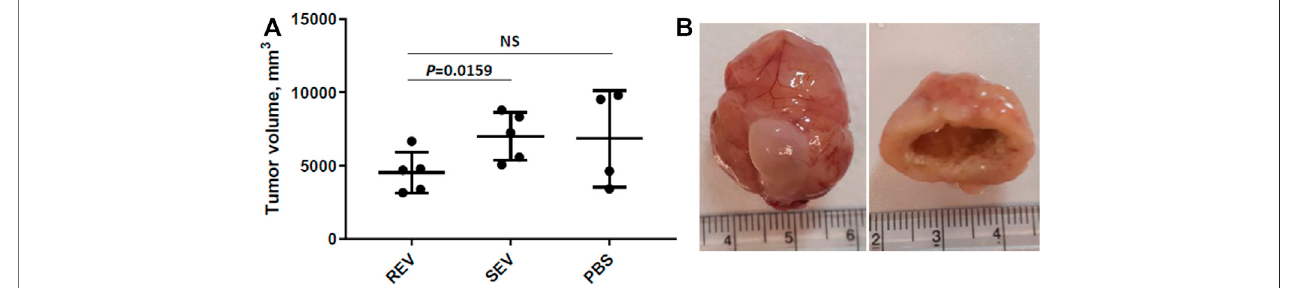
FIGURE4| Effectsofexercise-inducedEVsontheprogressionofprostatecancer. (A) Comparisonofprimarytumorvolumesbetweengroupsafter6 weeksofEV or vehicle administration. In the dot plot, mean tumor volumes are shown, whiskers represent standard deviation; dots represent individual animals. Mann-Whitney test wasperformedtoassessthestatisticalsigni fi canceofthedifferencesbetweengroups. (B) ArepresentativeexampleofanorthotopicPLS10cell-inducedprostatetumor (with bladder) and necrosis found in the center of most